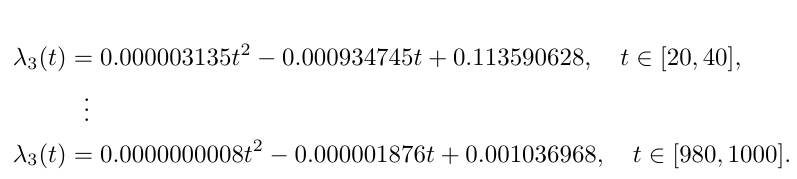
Figure 1. The ADM approximate ( M = 1, m = 20) and PADM solution ( M = 50, m = 2) of state